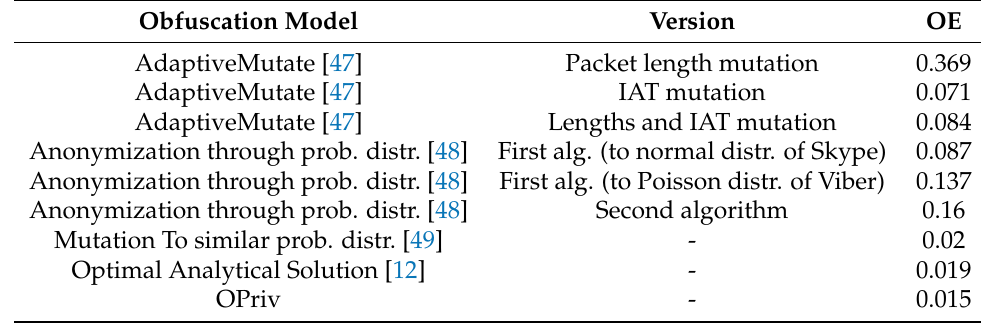
Table 16. Obfuscation effectiveness